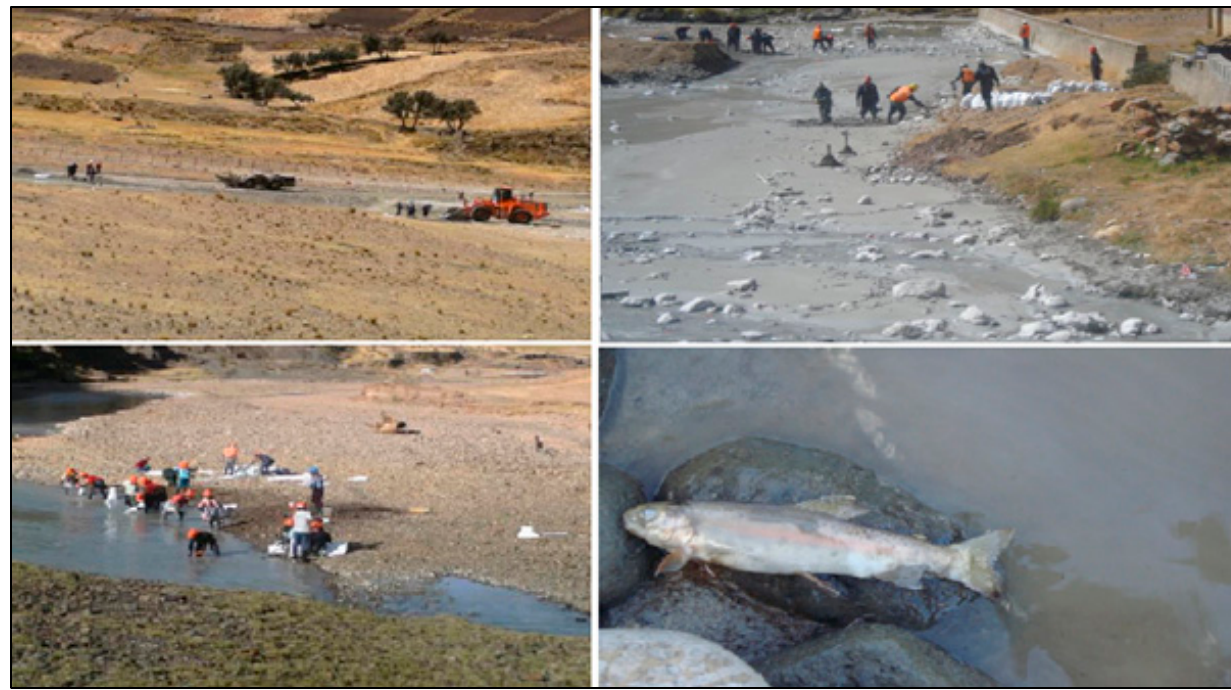
Figure 12. Tailings removal by community and miners, impacts on aquatic biota [45,46].